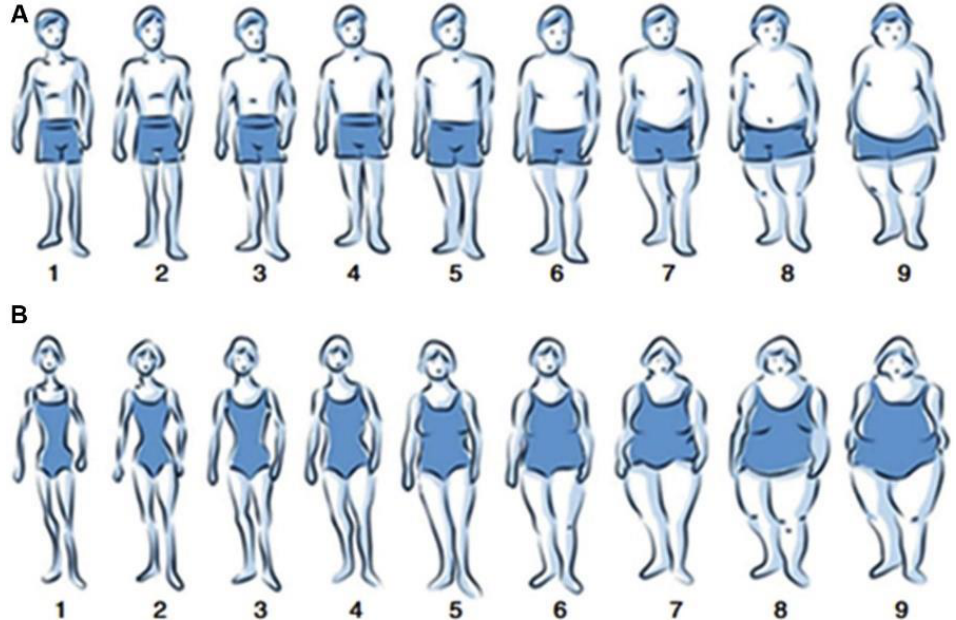
Figure 2. Body silhouettes for men ( A ) and women ( B ) used in the ECRHS/RHINE III studies and in the RHINESSA questionnaire survey. Cut-offs for overweight status were five or greater in men, and four or greater in women.